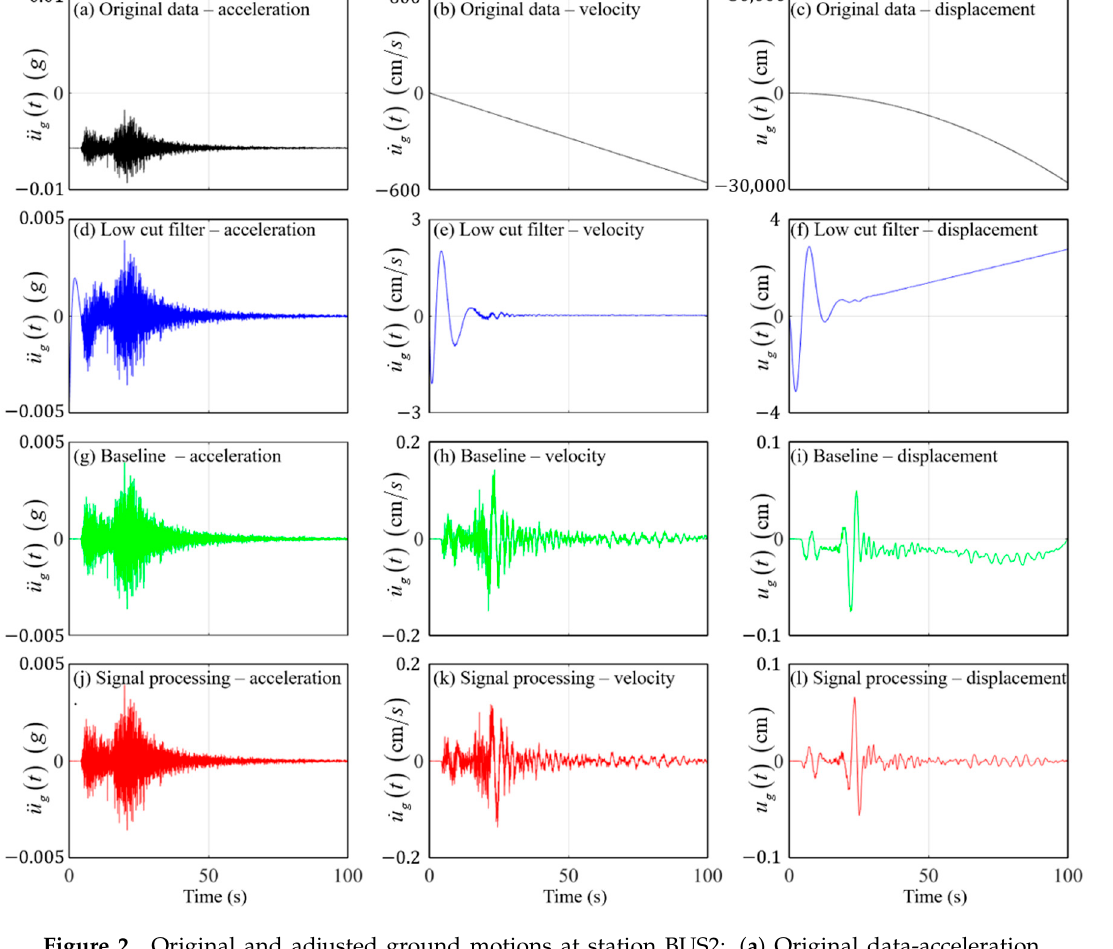
Figure 2. Original and adjusted ground motions at station BUS2: ( a ) Original data-acceleration, ( b ) Original data-velocity, ( c ) Original data-displacement, ( d ) Low cut filter-acceleration, ( e ) Low cut filter-velocity, ( f ) Low cut filter-displacement, ( g ) Baseline-acceleration, ( h ) Baseline-velocity, ( i ) Baseline-displacement, ( j ) Signal processing-acceleration, ( k ) Signal processing-velocity, ( l ) Signal processing-displacement.